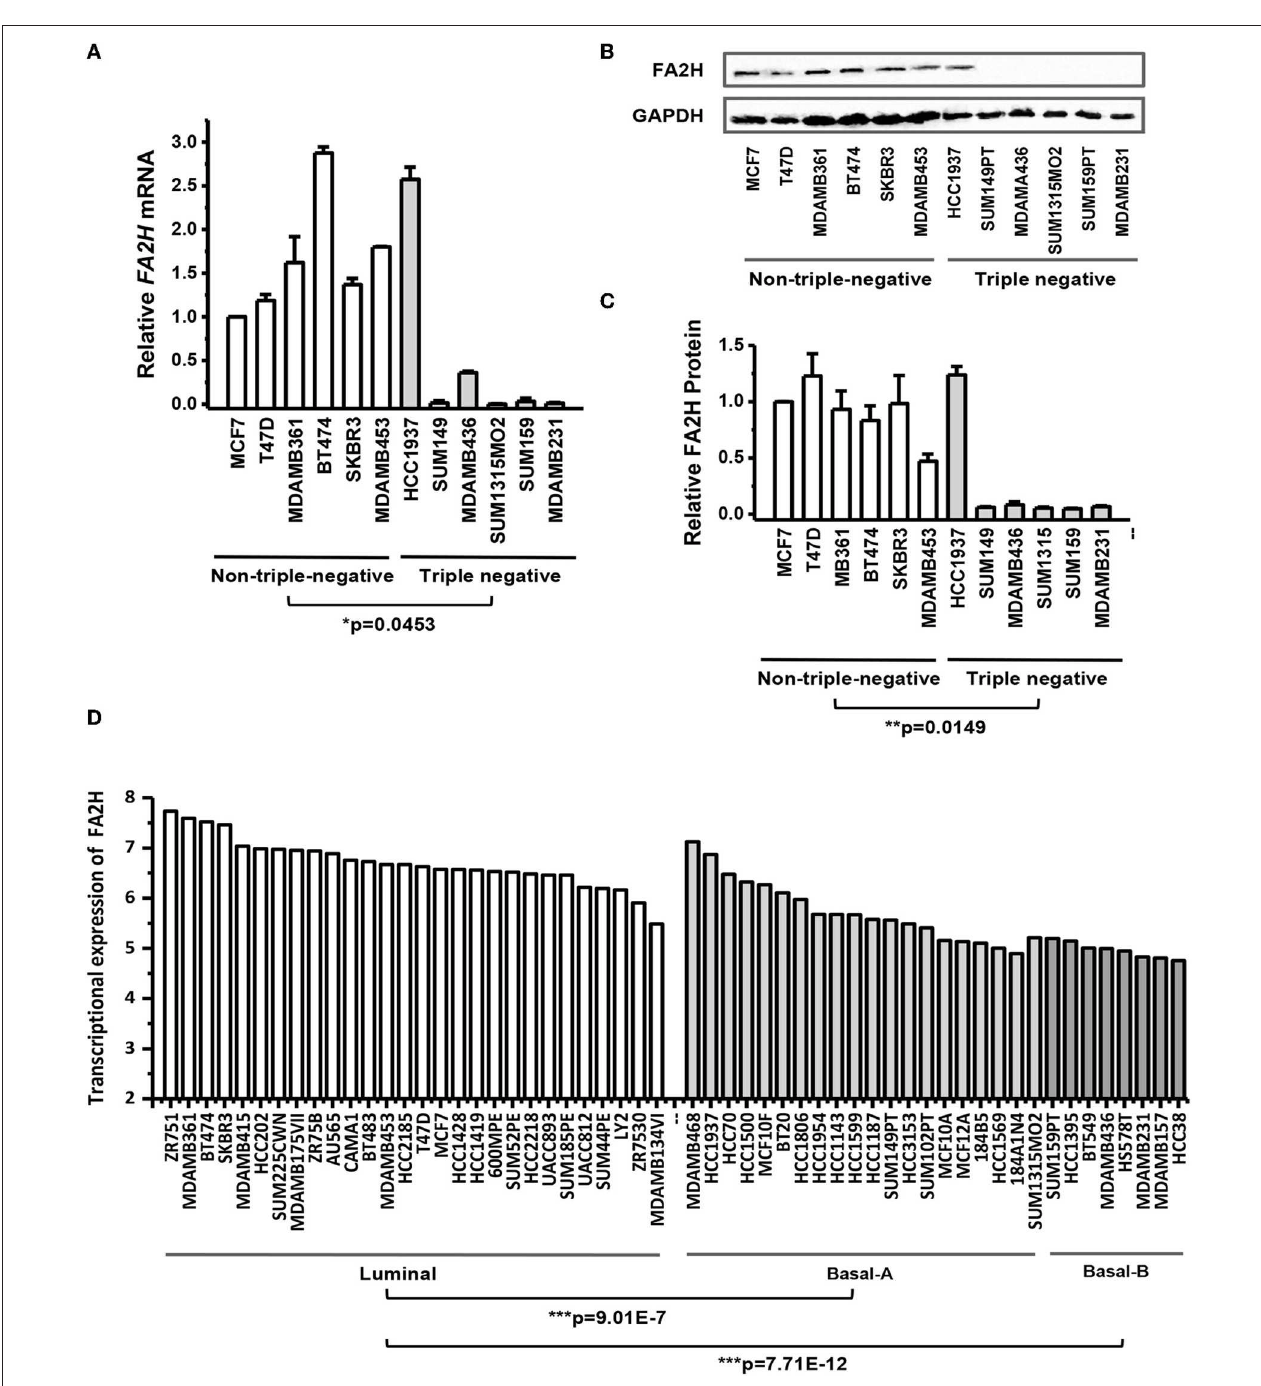
FIGURE 1 | FA2H expression among breast cancer cell lines. (A) FA2H gene expression among different breast cancer cell lines by qRT-PCR. (B) FA2H protein expression among different breast cancer cell lines by Western-blotting. (C) FA2H protein expression quantified using the ImageJ software. (D) FA2H gene expression across 56 breast cancer cell lines